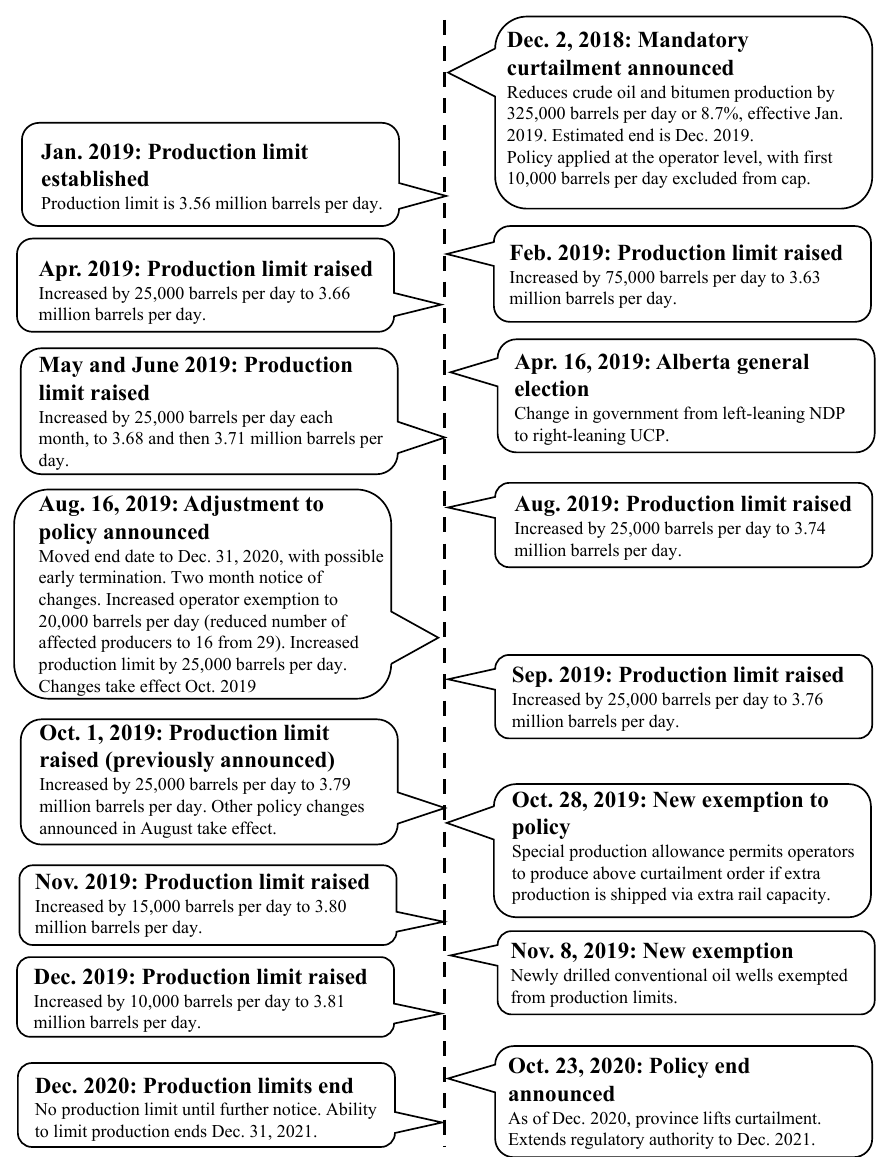
Figure 2. Curtailment Timeline. Clancy [10] reports 28 firms affected by curtailment in January 2019, but a subsequent government announcement in August 2019 states 29 firms were affected